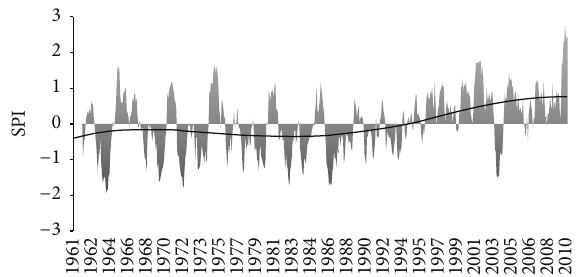
Figure3:Average12-monthSPIfortheTatraMountainsregion.The trend line is constructed by the curvilinear regression (fourth-order polynomial).